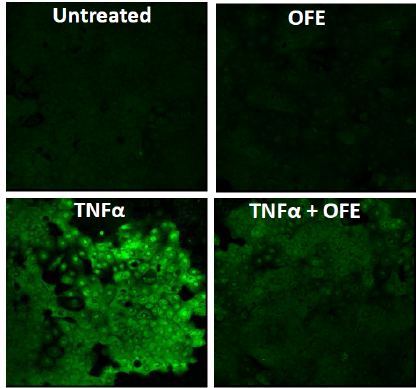
Figure 4. Antioxidant activity of Opuntia ficus-indica extract (OFE). Reactive oxygen species (ROS) are visualized with dichloro-dihydro-fluorescein diacetate staining (green). The production of ROS is not active in the untreated or OFE-treated human keratinocytes. Tumor necrosis factor α (TNF α ) induces ROS production, which is significantly inhibited by OFE (TNF α + OFE).